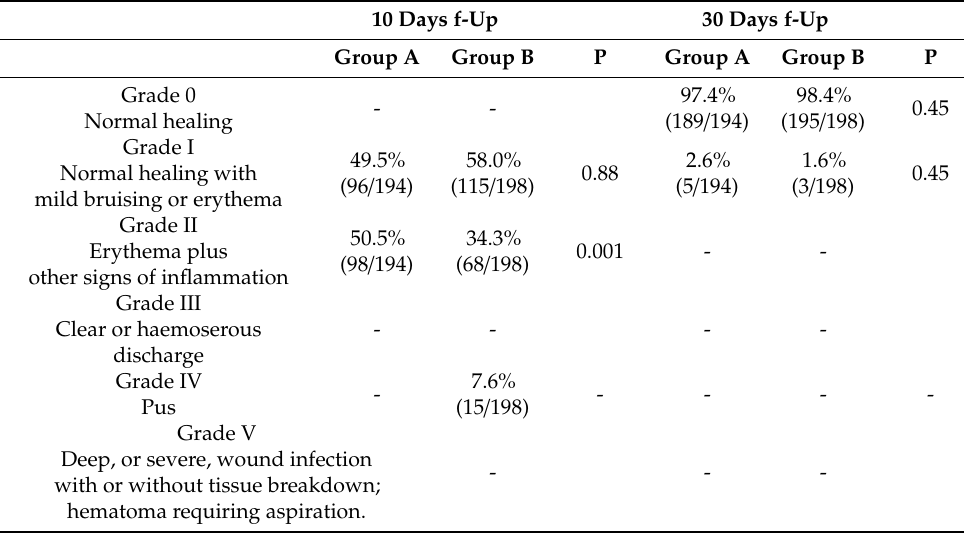
Table 2. Wound healing in the two groups analyzed by the Southampton Scoring System and Stony Brook Scar Evaluation Scale at 10- and 30-day